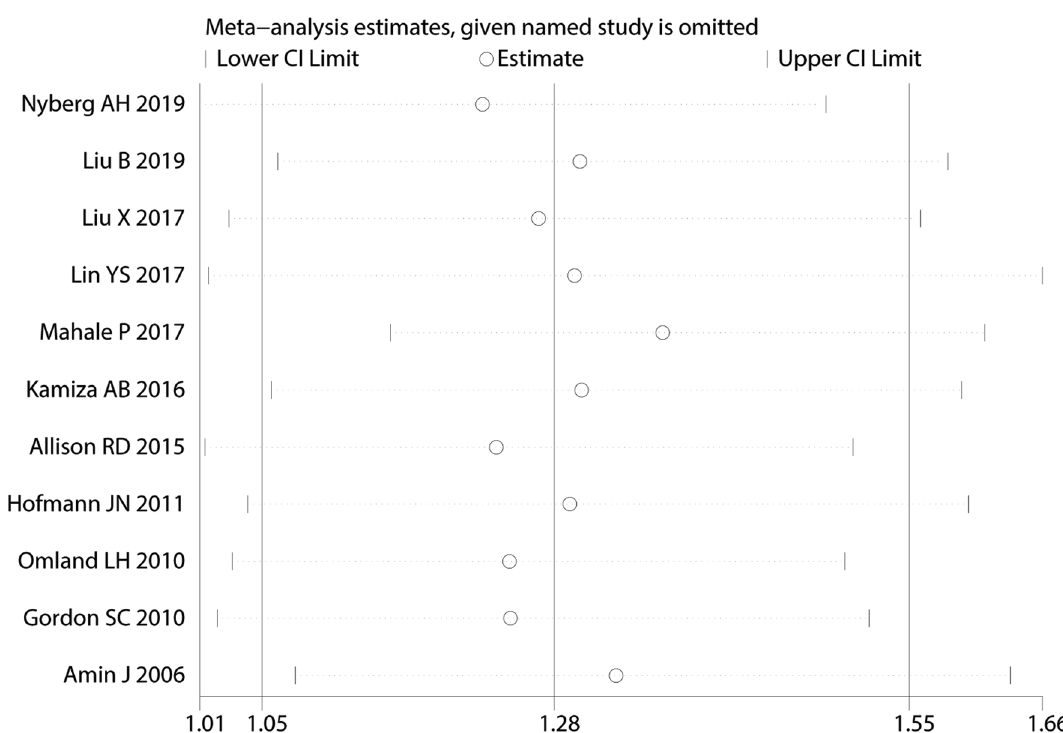
Figure 2. Sensitivity analyses by omitting individual study yielded nonsignificant RR